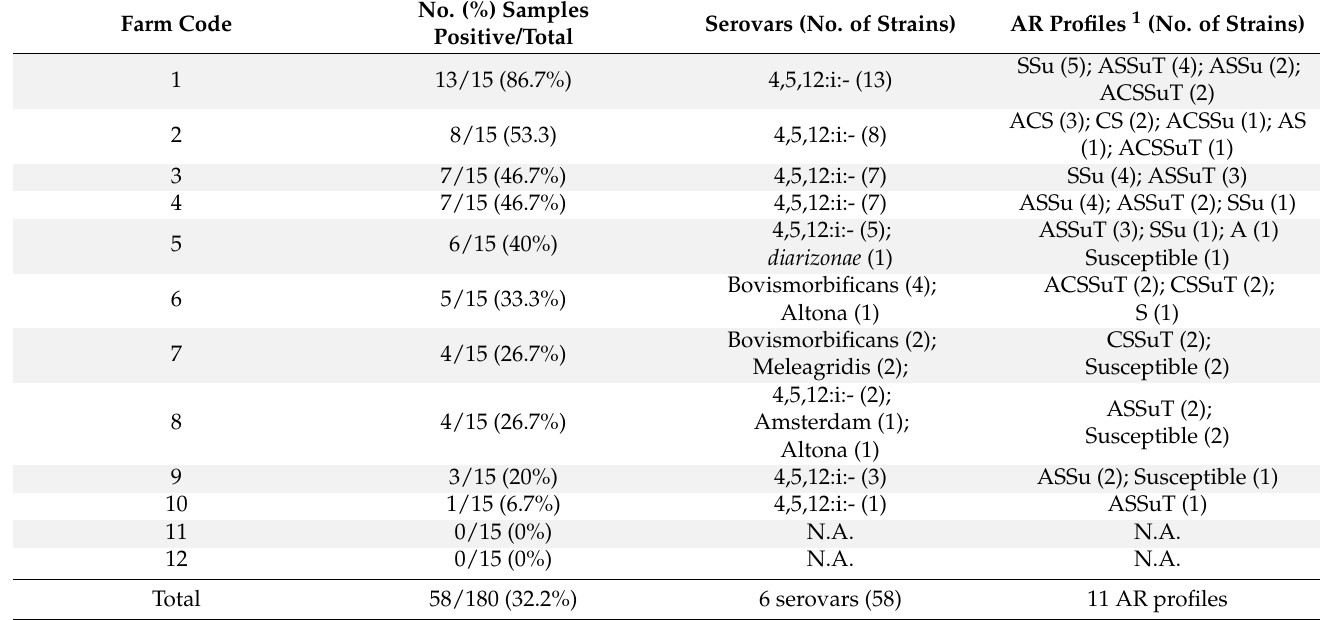
Table 2. Prevalence of Salmonella in the intestinal content of free-range pigs. Data are presented by farms, serovars and antimicrobial resistance (AR) profiles of the isolates